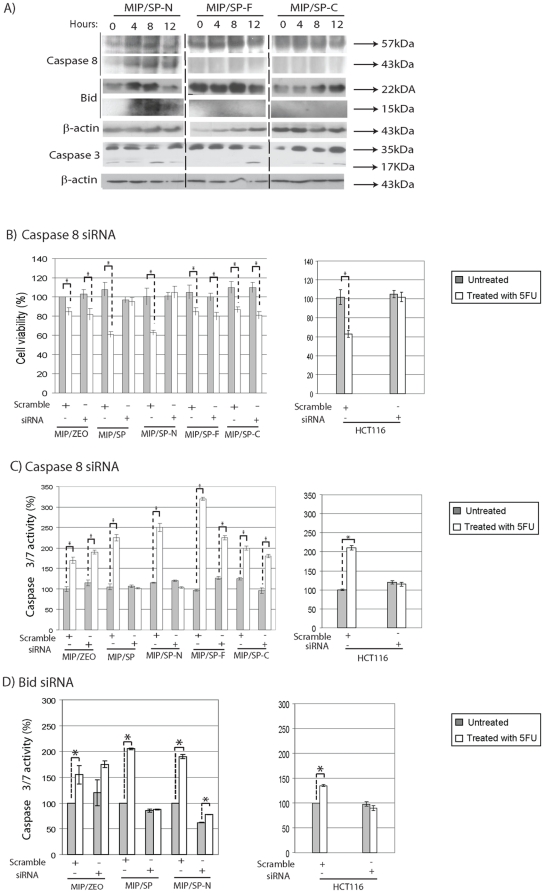
N-terminus domain of SPARC activates caspase 8 in response to treatment with 5-FU.
A) Changes in the expression of proteins involved in the apoptotic pathway following incubation with 5-FU at different time points in MIP101 cells stably overexpressing SPARC domains by immunoblotting. B–D) The contribution of caspase 8 or Bid in inducing SP-N-associated apoptosis were compared with various cell lines after transient transfection with caspase 8 and Bid siRNA (or scramble control) for 48 h, followed by no treatment (grey bars) or incubation with 5-FU (white or orange bars) for 24 h. Cell viability after caspase 8 siRNA transfection was assessed by WST assay (B), while apoptosis after caspase 8 (C) or Bid (D) siRNA transfection was assessed by caspase 3/7 assay. Results represent mean ± s.e. (n = 3–4 independent studies). *p<0.05, Student's t-test, in comparison to untreated controls.